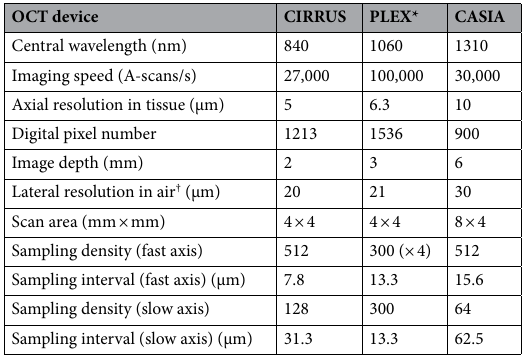
Table 3. Summary of AS-OCT devices. *PLEX was operated with an AS attachment of 20D with a focal length of 50 mm. The 3 × 3 AngioPLEX scan conducts 4-time repetition of B-scan for one location. † Lateral resolution of PLEX was estimated using the formula r = 0.8 · (cid:31) · f / D , where the beam diameter D estimated to be 2